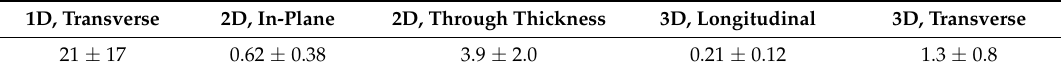
Table 3. The calculated β values for different macro-pore structures.